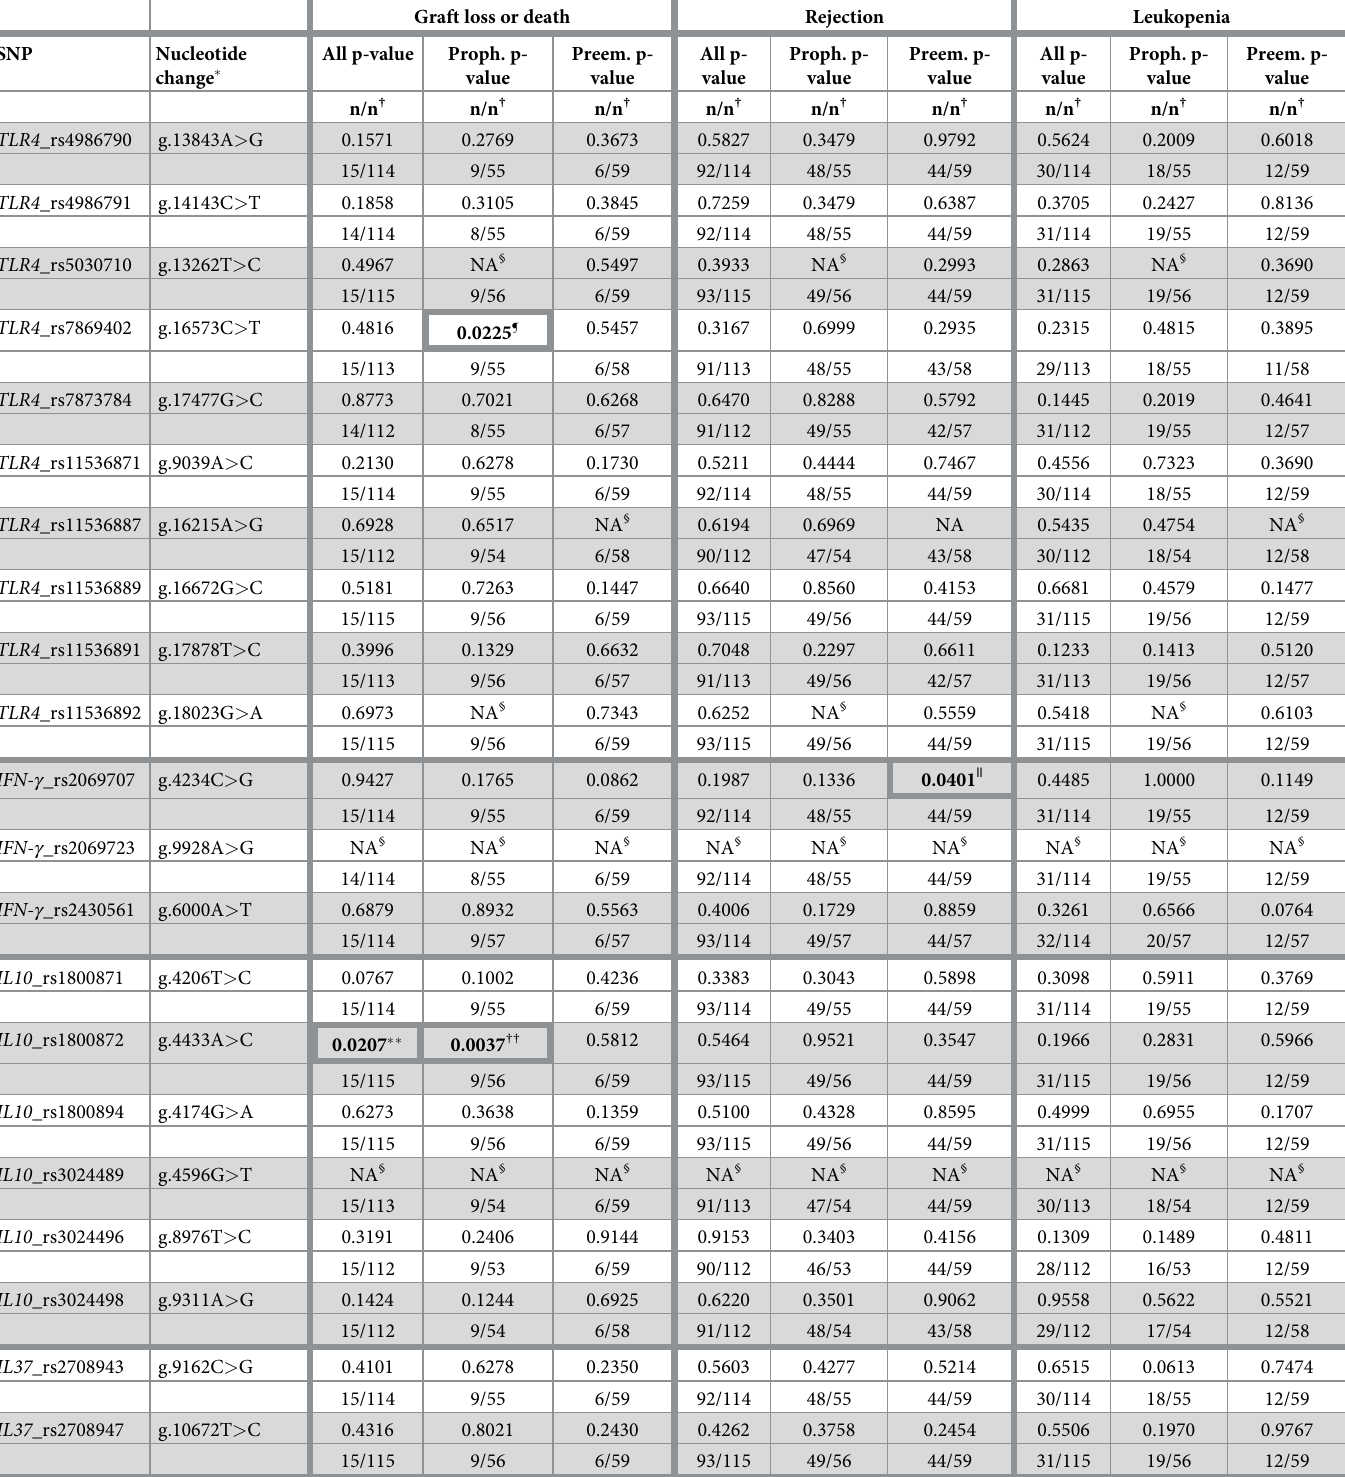
Table 3. Statistical analysis of the association between genetic variants and the clinical events graft loss or death, rejection and leukopenia in all patients, and in the prophylaxis and preemptive treatment